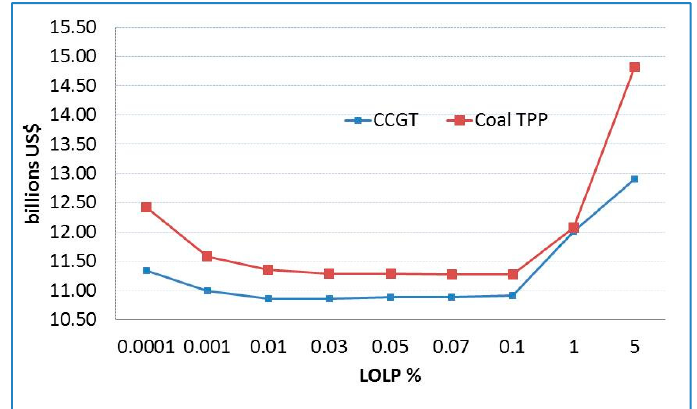
Figure 6. LOLP optimization of LOLP for VOLL $10 USD/kWh with CCGT and coal fired TPP.